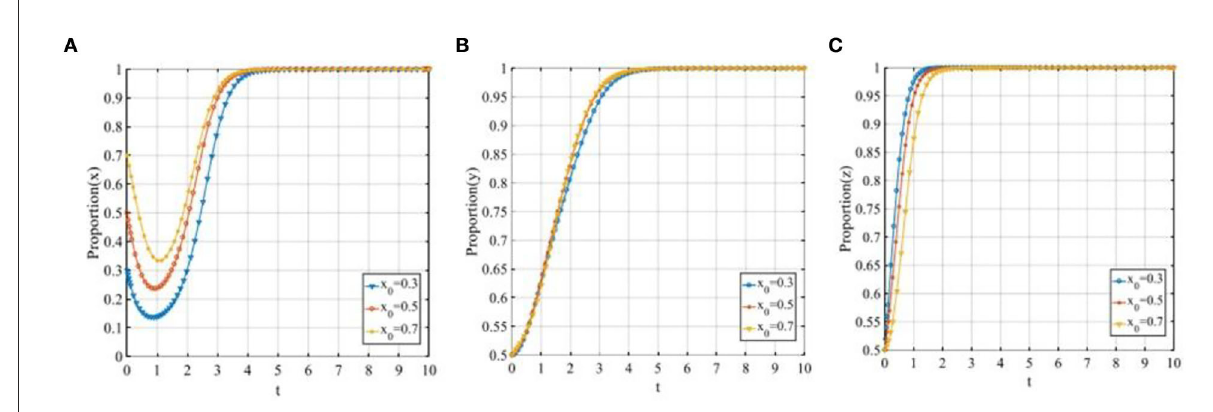
FIGURE4 The evolutionary trajectories of three participants when x 0 = 0.3, 0.5, 0.7. (A) The sensitivity of P2P lending platforms; (B) The sensitivity of investors; and (C) The sensitivity of financial